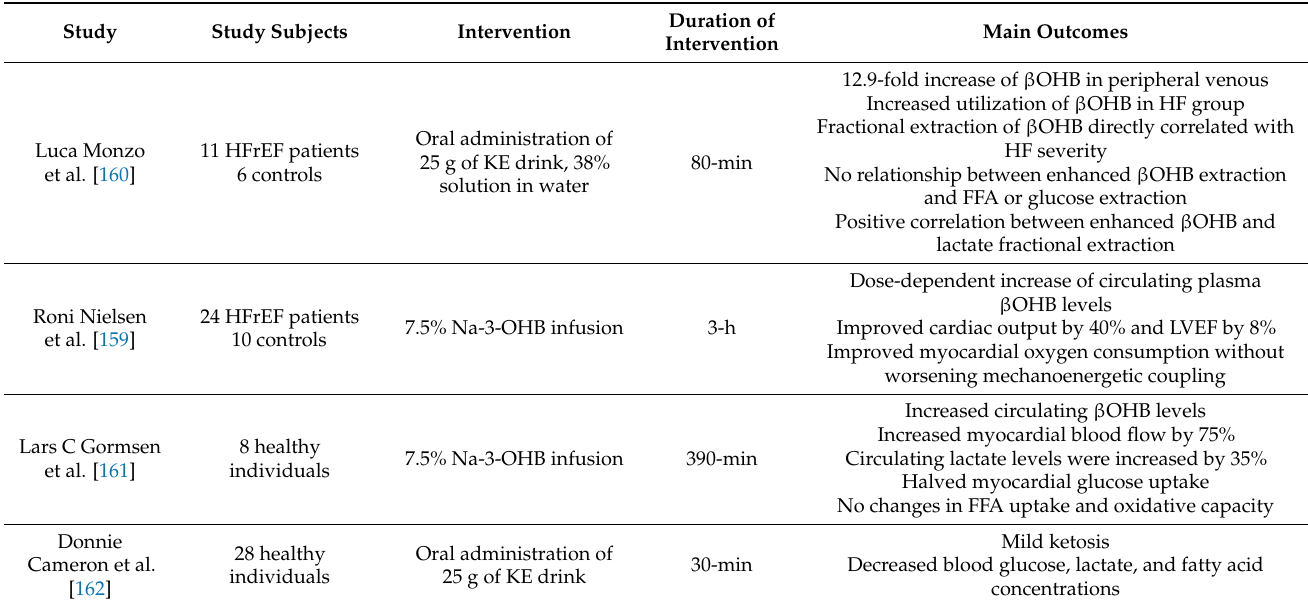
Table 1. Exogenous ketones administration on cardiac metabolism in healthy individuals or heart failure